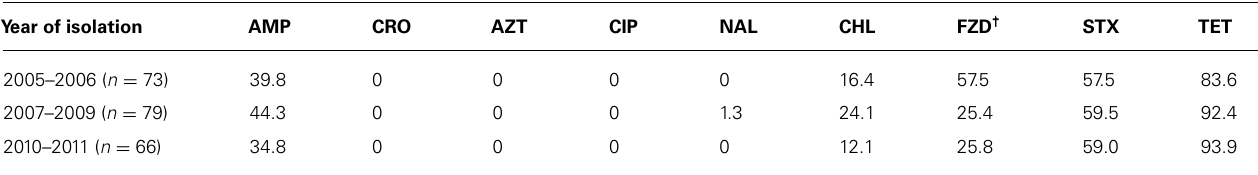
AMP, ampicillin; AZT, azithromycin; CAZ, ceftazidime; CHL, chloramphenicol; CIP, ciprofloxacin; CRO, ceftriaxone; FZD, furazolidone; GEN, gentamicin; NAL, nalidixic acid, STX, trimethoprim–sulfamethoxazole;TET, tetracycline. *Includes resistant and intermediate strains. † Difference from 2005 to 2011: p < 0.001.